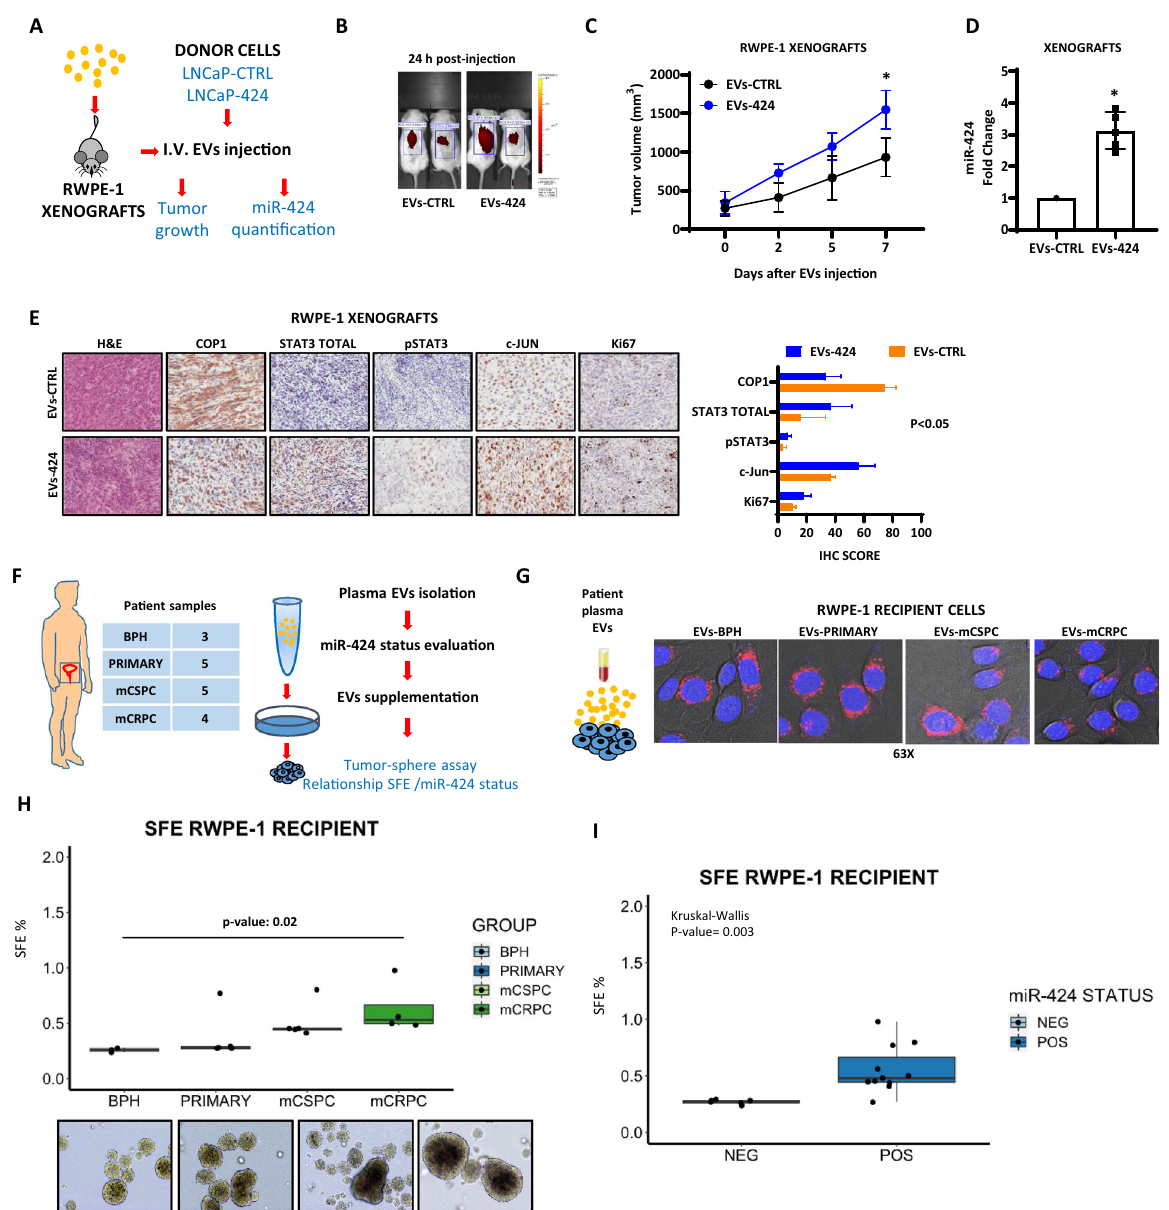
Fig. 7 Circulating miR-424-loaded EVs are oncogenically active in mouse models and human patients. A Schematic plan for in vivo assessment of EVs functionality. B In vivo imaging of distribution of DiD-labeled EVs from control (EVs-CTRL) and miR-424 expressing (EVs-424) donor cells 24 h after intravenous injection to NSG mice with RWPE-1 xenografts. C Growth of RWPE-1 xenografts following single tail vein injection of EVs-CTRL and EVs-424 ( n = 4/group). D miR-424 level in RWPE-1 xenografts in mice injected with EVs-CTRL and EVs-424. E Assessment of protein markers by IHC in RWPE-1 xenografts from mice injected with EVs-CTRL and EVs-424. Right, IHC scores for each protein markers. F Functional assessment of patient-derived EVs in recipient RWPE-1 cells. G Confocal microscopy images of RWPE-1 cells supplemented with patient-derived EVs stained with PKH26 (red). H Tumor-sphere forming assay of RWPE-1 cells supplemented with EVs derived from the indicated patient groups. Bottom, representative images of tumor-spheres. I Tumor-sphere forming ef fi ciency of recipient cells as in H shown in relation to miR-424 status after supplementation of patient-derived EVs. * p ≤ 0.05, ** p ≤ 0.01 by two-tailed Student ’ s t -test. Following on reports that miR-424 expression promotes oncogenesis, Domenico Albino et al. fi nd that extracellular vesicles (EVs) in the plasma of prostate cancer patients secrete miR-424. Using cell-based and animal models, they demonstrate that EV- mediated release of miR-424 can transfer oncogenic signals across cells to promote recurrence and metastatic